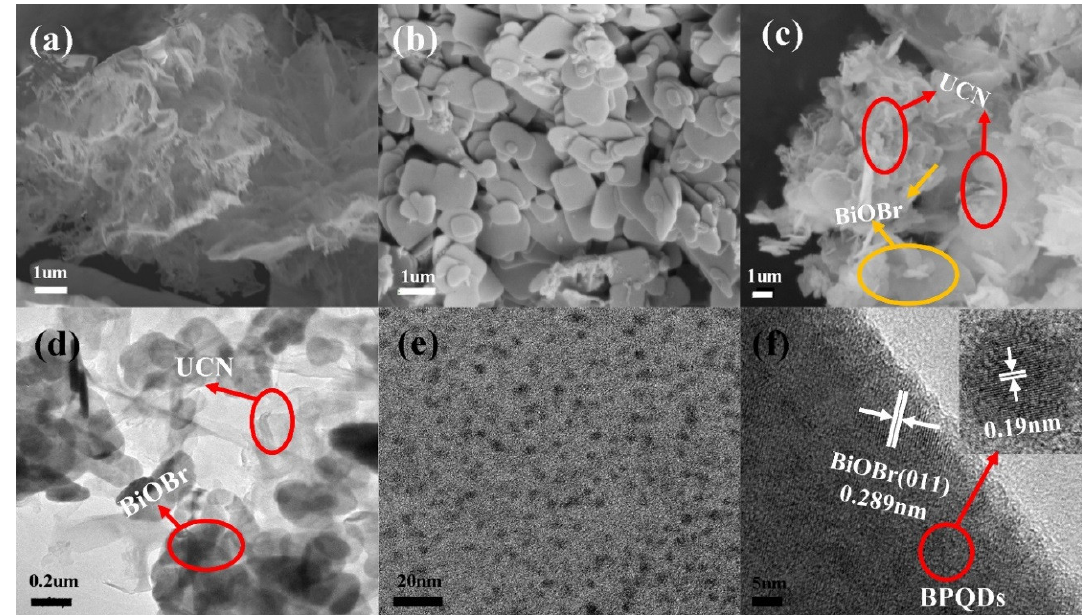
Figure 2. SEM images of ( a ) ultrathin g-C 3 N 4 nanosheets, ( b ) BiOBr nanosheets, and ( c ) BiOBr/UCN/BPQDs ternary heterostructure. TEM images of ( d ) BiOBr/UCN, ( e ) BPQDs, and ( f ) BiOBr/UCN/BPQDs ternary heterostructure.